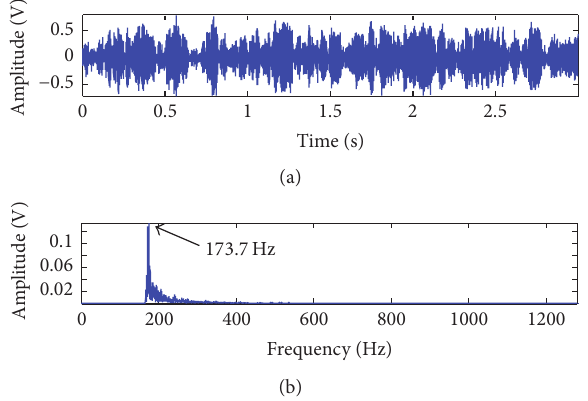
Figure 18: The enhanced result of IMF3 with an inner fault via adaptive stochastic resonance: (a) time-domain waveform; (b) frequency spectrum.